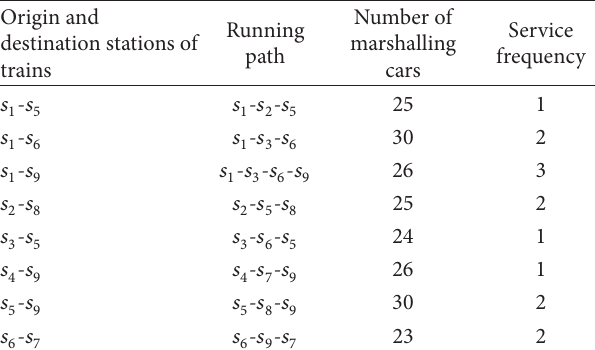
Table 3: Operation plan of express freight trains. Origin